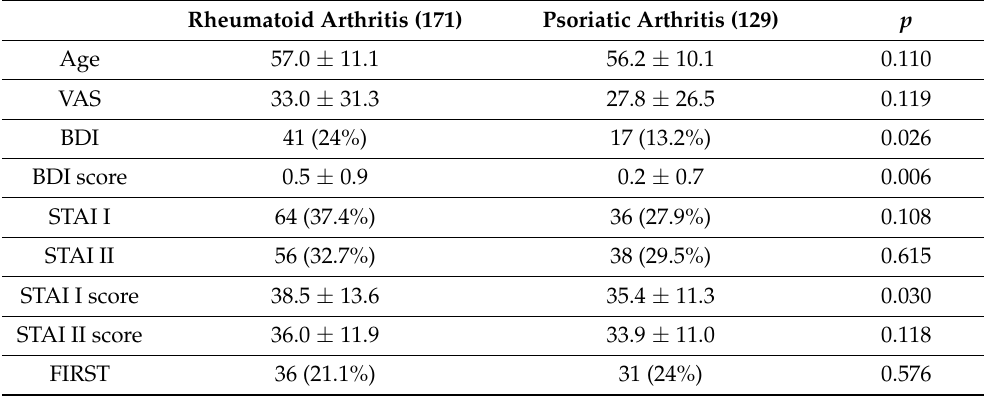
Table 1. Demographics and value at test. Rheumatoid Arthritis (171) Psoriatic Arthritis